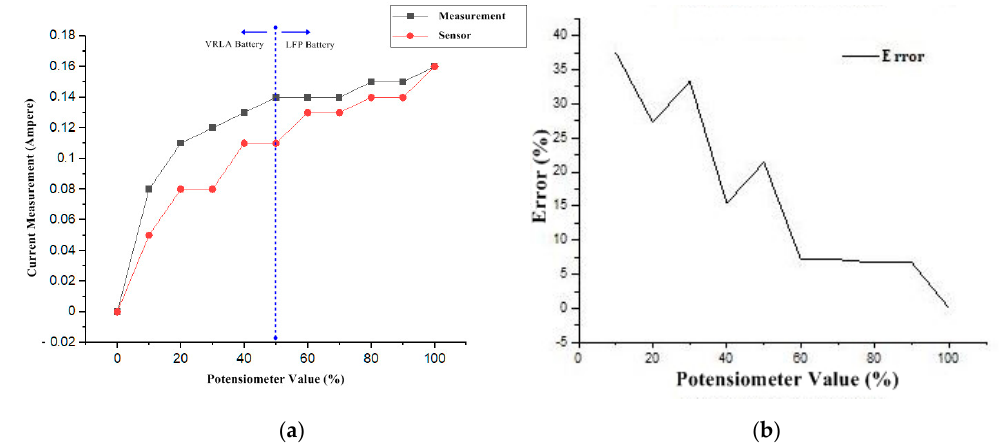
Figure 13. Graph of current sensor: ( a ) Current value reading; ( b ) Error value.